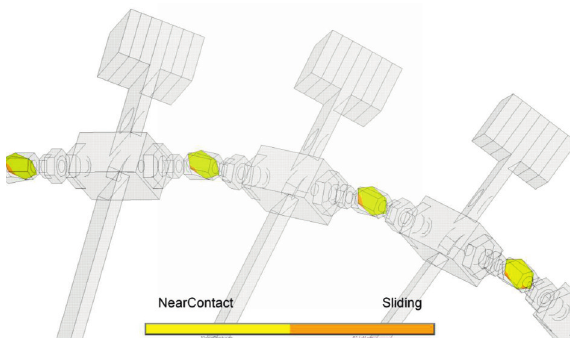
Figure 17: Detail of contact statuses (near contact and sliding) at tie-boss couplings (detail) at 0.096745 s—2ND mode.